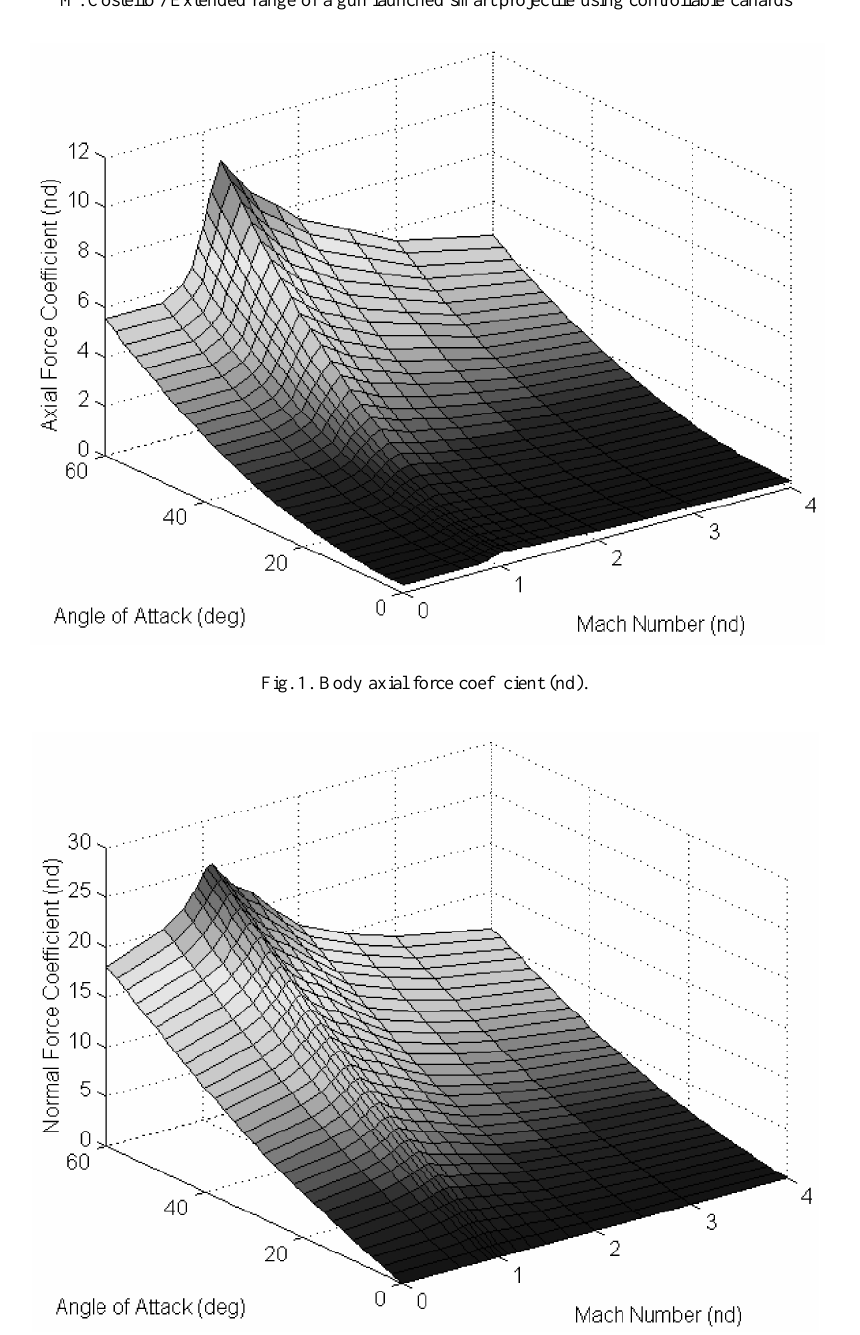
Fig. 2. Body normal force coefficient